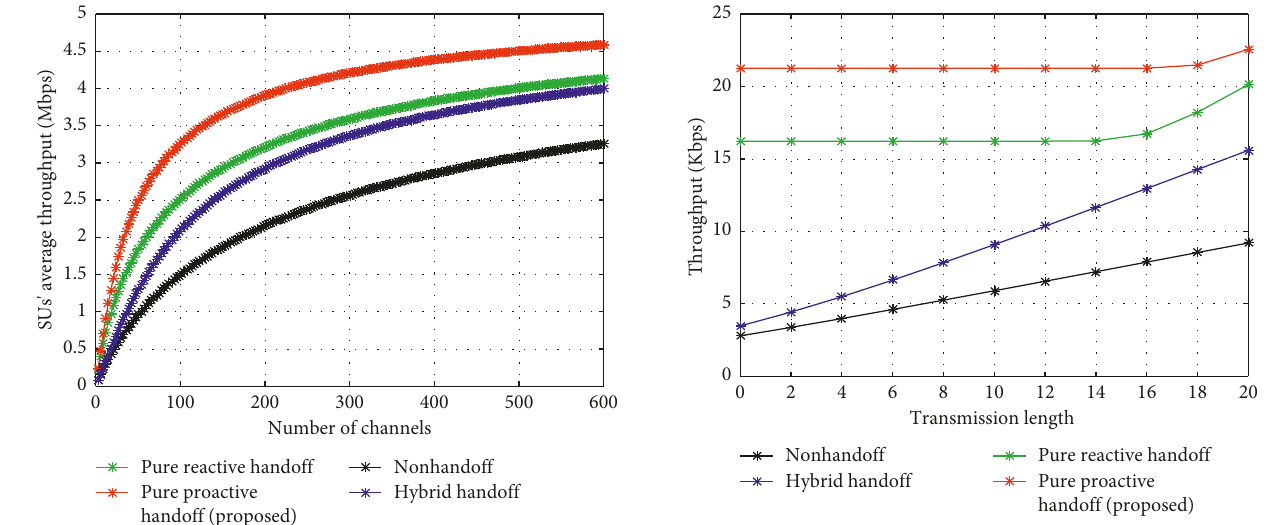
Figure 11: Illustration of performance in terms of throughput versus a number of channels spectrum handoff